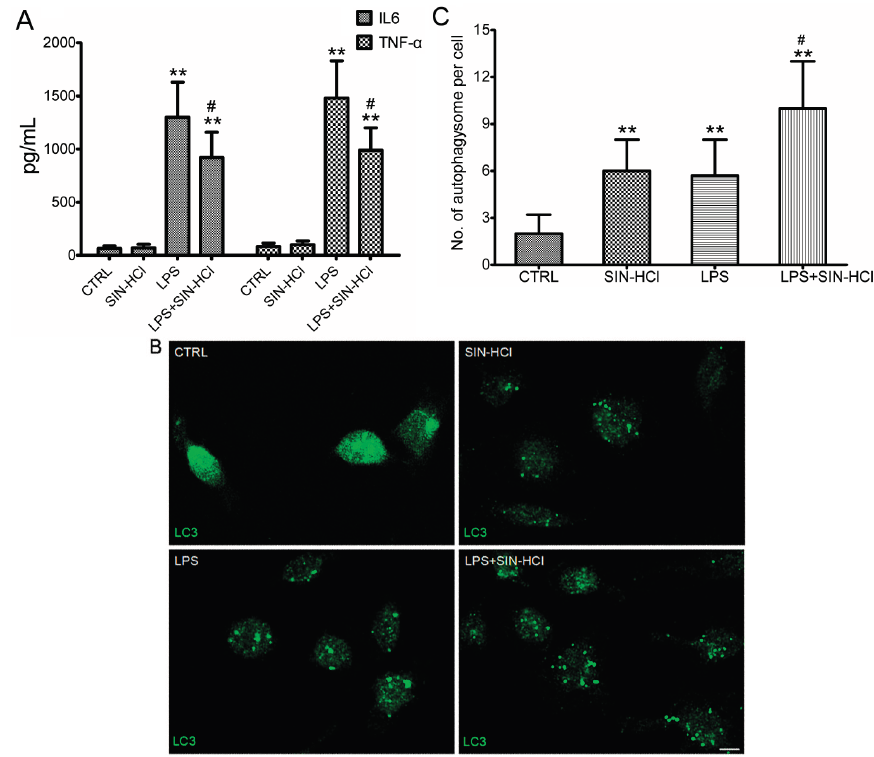
Figure 4. SIN-HCl blocked LPS-induced inflammatory cytokine release and increased autophagy in peritoneal macrophages (PM). ( A ) Primary PM were cultured for 12 h with LPS (100 ng/mL), SIN-HCl (100 mM), or a combination of these two reagents (as indicated). The levels of IL-6 and TNF- α in culture media were measured. ** p < 0.01 when compared with PBS group, n ≥ 6; # p < 0.05 when compared with the LPS group, n ≥ 6; ( B ) Primary PM were treated with LPS (100 ng/mL), SIN-HCl (100 mM), or a combination of these two reagents (as indicated) for 12 h before immunofluorescent detection of LC3 protein using an anti-LC3 antibody, Scale bar = 10 μ m and ( C ) Autophagosomes per cell in PM were counted in at least 30 cells. ** p < 0.01 when compared with PBS group, n ≥